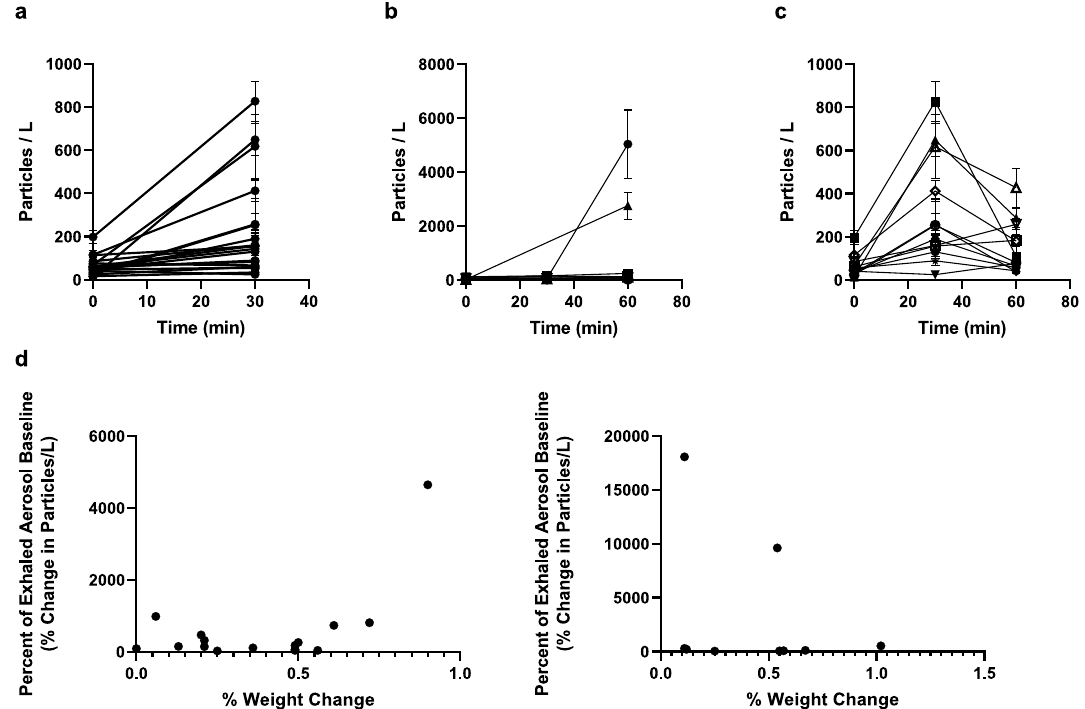
Figure 3. Exhaled aerosol particle numbers from healthy human subjects in an exercise-induced dehydration study. Shown are ( A ) all subjects before and after 30 min of exercise; ( B ) all non-treatment control subjects before, during and after 60 min of exercise; ( C ) all active subjects before and after administration at 30 min of exercise of upper-airway salts; ( D ) all subjects as a function of dehydration weight loss over the course of the exercise-induced dehydration study after 30 min (left) and all control subjects after 60 min (right). Error bars represent standard errors of the calcium-rich hypertonic salts to the upper airways on exhaled aerosol, oxygen saturation, and disease symptoms in a randomized double-blinded nasal-saline control study of 40 moderately symptomatic COVID-19 patients admitted into Bangalore Baptist Hospital during the period May–June when the delta variant predominated infections in India 50 . Most of the COVID-19-positive subjects in the two arms of the study entered the hospital with fever, cough, body pain and loss of smell or taste sensation (Table 1), and mean initial self-reported symp- tom scores of 3.15 ± 0.17 (no statistical difference in symptom scores was observed between the two groups, P = 0.599). Three of the subjects in the active group were escalated to intensive care prior to completing the three days of treatment and were therefore excluded from the post-treatment results. See Table 1. Administration of the active reduced exhaled aerosol in all subjects (Fig. 4A) 30 min post administration, and for all but one subject for the duration of the assessment (up to 2 h post administration). Administration of the Simply Saline control (Fig. 4B) did not change overall exhaled aerosol for the group (P = 0.122), while some subjects did exhale fewer respiratory droplets post administration of the nasal saline control, suggesting the possibility that some patients in the control arm of the study may have experienced an active effect of the nasal saline on aerosol generation in the trachea given prone positions in hospital beds and post-nasal drip, a possibility further discussed in the Supplemental Material. Oxygen saturation levels began at similar levels for the active and control groups at the start of the study (Fig. 4B). Over the course of the three days of administration, oxygen saturation rose significantly (P = 5.981e−07) in the active group and did not change (P = 0.533) in the Simply Saline control group (Fig. 4B). Daily reduction of self-reported symptom scores was observed in the active group from Day 2 with 86% of all subjects discharged without symptoms while 0% of the control group ended their stay in the hospital without symptoms (Fig. 4D). Among the subjects of each group who entered the trial with elevated CRP levels (CRP > 10 mg/mL), intra- venous antibiotics or steroids were needed in only 25% of the active group (n = 8) versus 63.64% of the saline control group (n = 11) (Fig. 4C). CRP levels fell from day 1 to day 3 in 75% of the active group and in 52.6% of the control group (Table 1). We further monitored exhaled aerosol, symptoms scores and oxygen saturation levels for 10 of the 37 non- treated subjects over the course of their hospitalization as reported in the Supplemental Material. Oxygen satu- ration levels and treatment scores remained unchanged from admission to release from the hospital (see Sup- plemental Material).